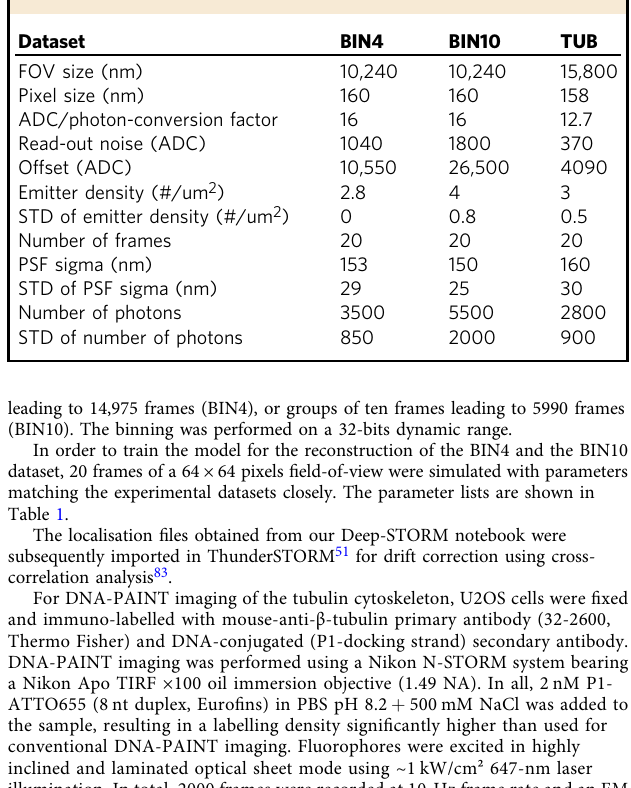
Table 1 Simulation parameters used to generate training data for Deep-STORM